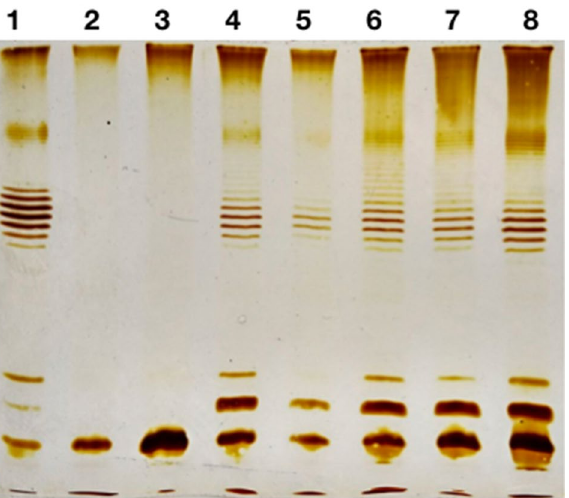
Figure 3. Complementation of the wclH mutation from the plasmid on phi24B lysogens background. Lanes 1— E. coli 4s wild type, 2—4sR, 3—4sR (phi24B), 4—4sR:pWclH, 5—the same as lane 4 with less sample load, 6—8 three clones of